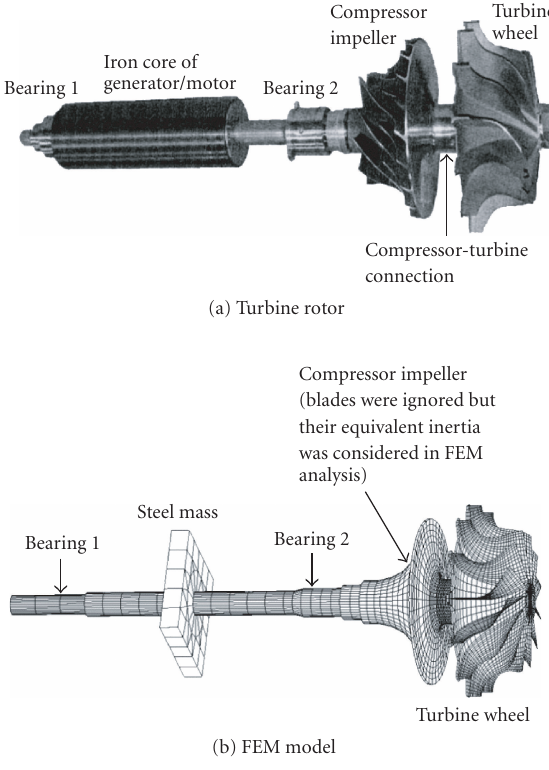
Figure 5: The turbine rotor and its FEM